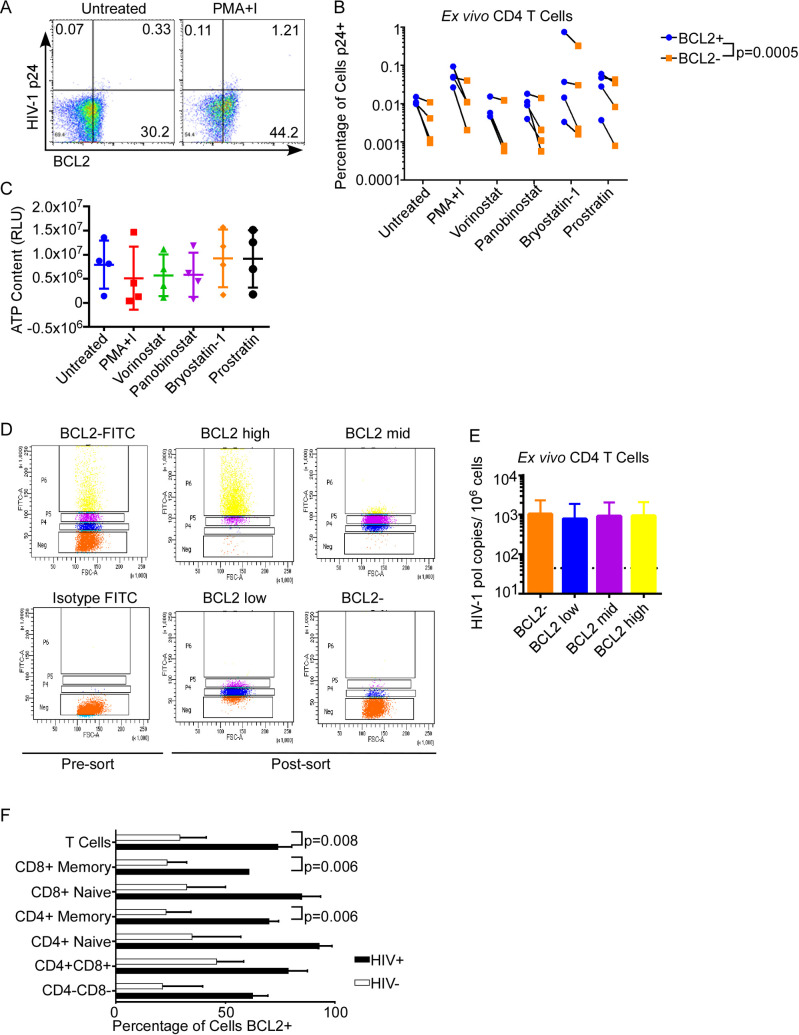
BCL2+ T cells Occur More in HIV-1+ Donors than in Uninfected Donors and Express More p24 than BCL2- cells.A-B) Primary CD4 T cells from HIV positive donors were treated ex vivo with a panel of LRAs at physiologic concentrations, and assessed for intracellular BCL2 and HIV-p24 expression by flow cytometry. Representative FACS plots on unstimulated and maximally stimulated cells are in (A). Full data are represented in (B). A ratio paired t test comparing BCL2+ cells and BCL2- cells in all treatment conditions was used to assess statistical significance. C) Potential LRA-induced proliferation or toxicity was assessed in the treated CD4 T cells from (A-B) by measuring ATP content. D-E) Ex vivo CD4 T cells from 4 ART-suppressed, HIV positive donors were FACS sorted by intracellular BCL2 expression (D) and total HIV DNA measured in sorted cells by digital droplet PCR (E). F) PBMCs from healthy donors and HIV-positive persons were stained for T cell subsets using Live/Dead, CD3, CD4, CD8, CD27, and CD45RO. BCL2 expression in T cell subsets from healthy donors and HIV-infected persons were compared. Statistical significance was determined using multiple t tests.